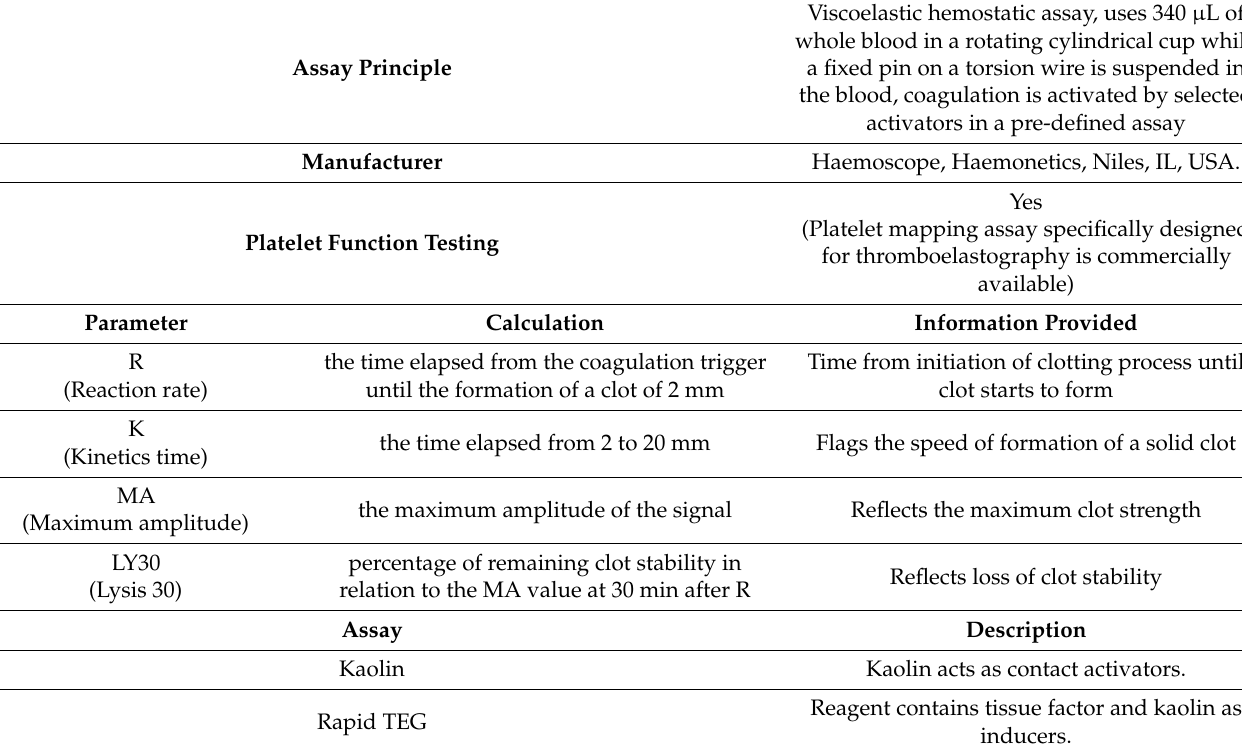
Table 1. Thromboelastography (TEG ®